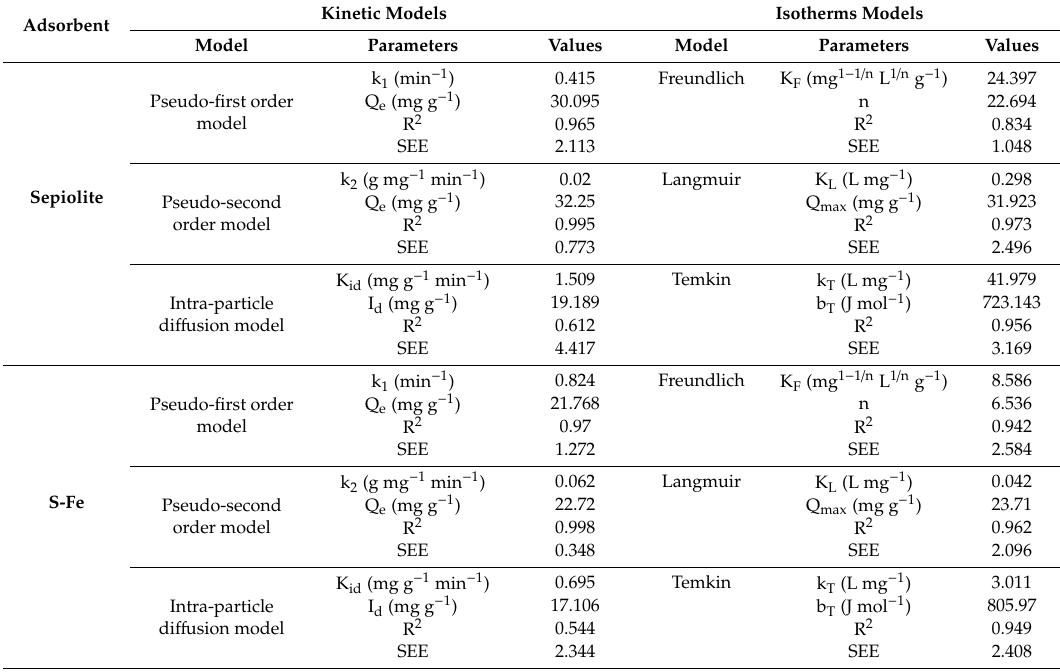
Table 3. Parameters of kinetic and isotherm models used for fitting [bpy] Cl adsorption into sepiolite and S-Fe. Experimental conditions: adsorbent = 1 g; V s = 50 mL; 150 rpm; T = 25 ◦ C; the contact time was fixed at 2 h for kinetics experiments and 16 h for the isotherms experiments.